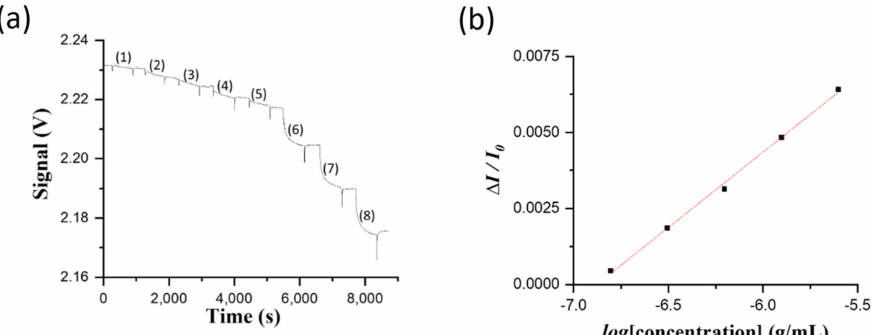
Figure 5. ( a ) The sensorgram obtained by sequentially injecting NNV coat protein standard solutions at concentrations of (1) 1.4 × 10 − 7 , (2) 2.8 × 10 − 7 , (3) 5.6 × 10 − 7 , (4) 1.25 × 10 − 6 , (5) 2.5 × 10 − 6 , (6) 5.0 × 10 − 6 , (7) 1.0 × 10 − 5 , and (8) 2.0 × 10 − 5 to g/mL. ( b ) The corresponding standard cali- bration curve of the normalized response ( ∆ I/I 0 ) versus the logarithm value of NNV coat protein concentration (log[C]), over the range of 1.4 × 10 − 7 to 2.5 × 10 − 6